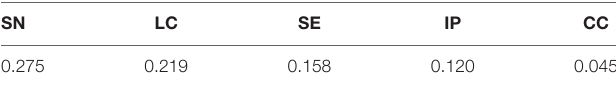
TABLE 4 | R-squared